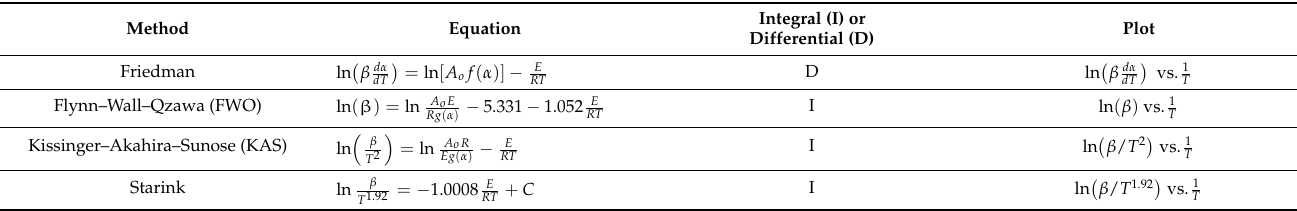
Table 2. Equations for four model-free